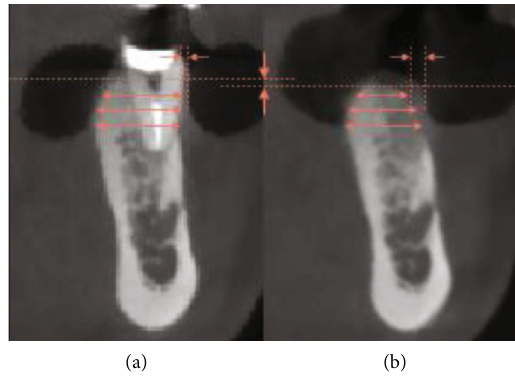
Figure 8: CBCT sagittal view with an illustration of radiological measurements: (a) Before the extraction; (b) 4 months post-op (vertical di ff erence of bone levels; horizontal bone width at 2, 4, and 6 mm; soft tissue thickness at the buccal side).